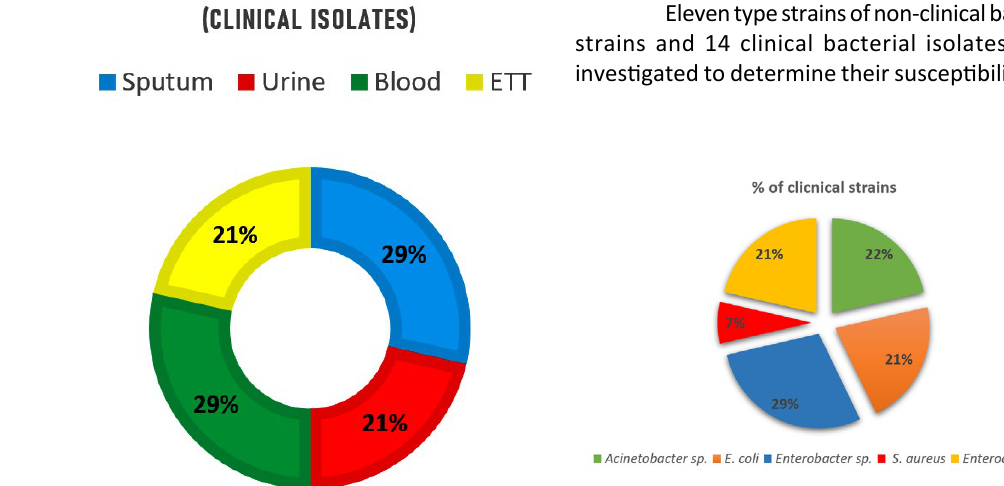
Fig. 1. A doughnut chart represents the percentage of the clinical bacterial isolates according to the site of isolation.